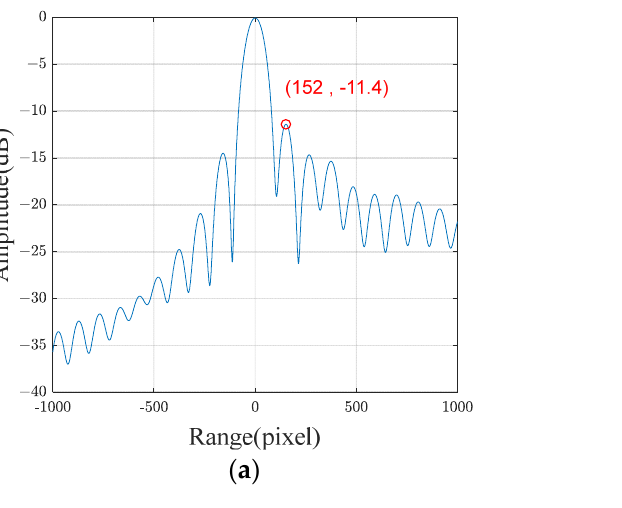
Figure 8. Results of range profile and azimuth profile. ( a ) Range profile. ( b ) Azimuth profile.